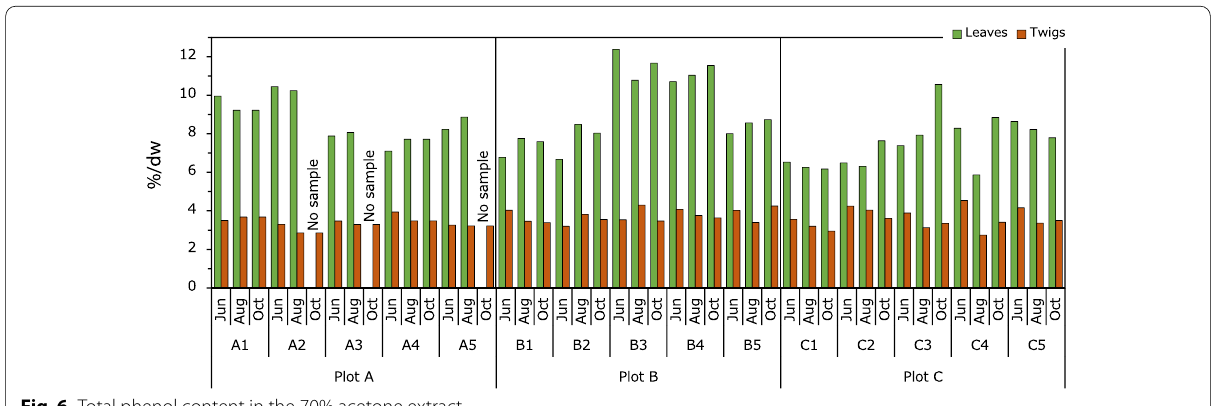
Fig. 6 Total phenol content in the 70% acetone